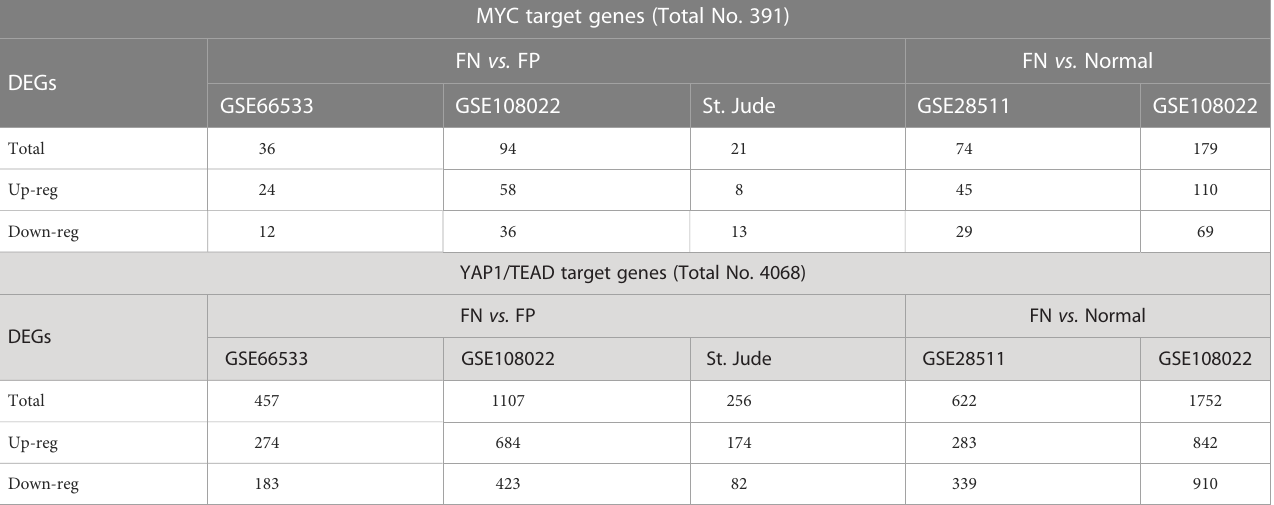
TABLE 5 Target genes differential expression in multiply